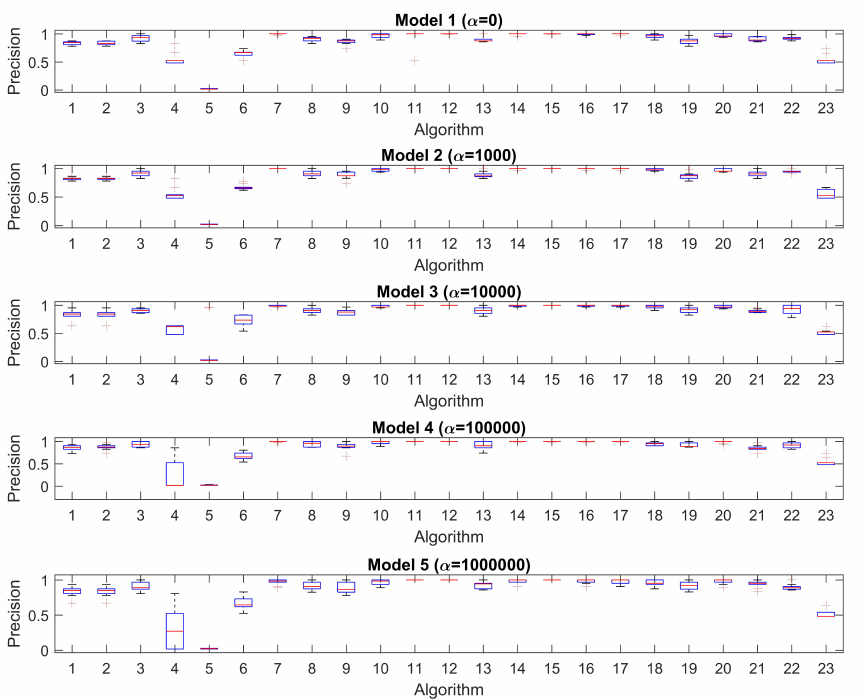
Figure A7. Numerical simulation Assumption 3 (constant). Precision of various models after permutations in the numerical values of the mapping. The 23 algorithms are represented in the x -axis, and the accuracy is shown in the y -axis.